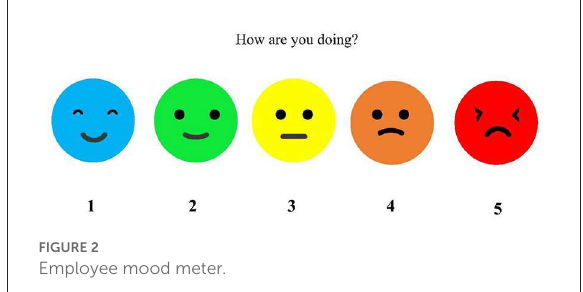
FIGURE2 Employee mood